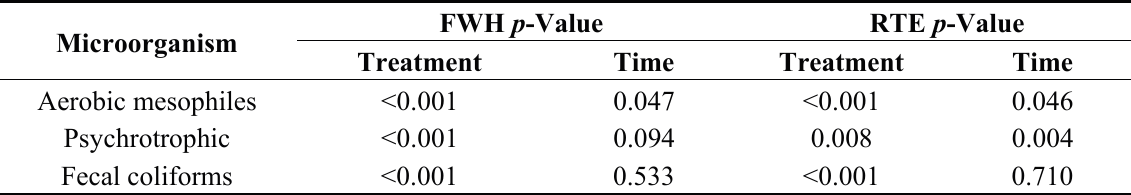
Table 5. Results of the Kruskal–Wallis test regarding the different times and types of treatment applied to the fresh whole head (FWH) and ready-to-eat (RTE) lettuce. p =